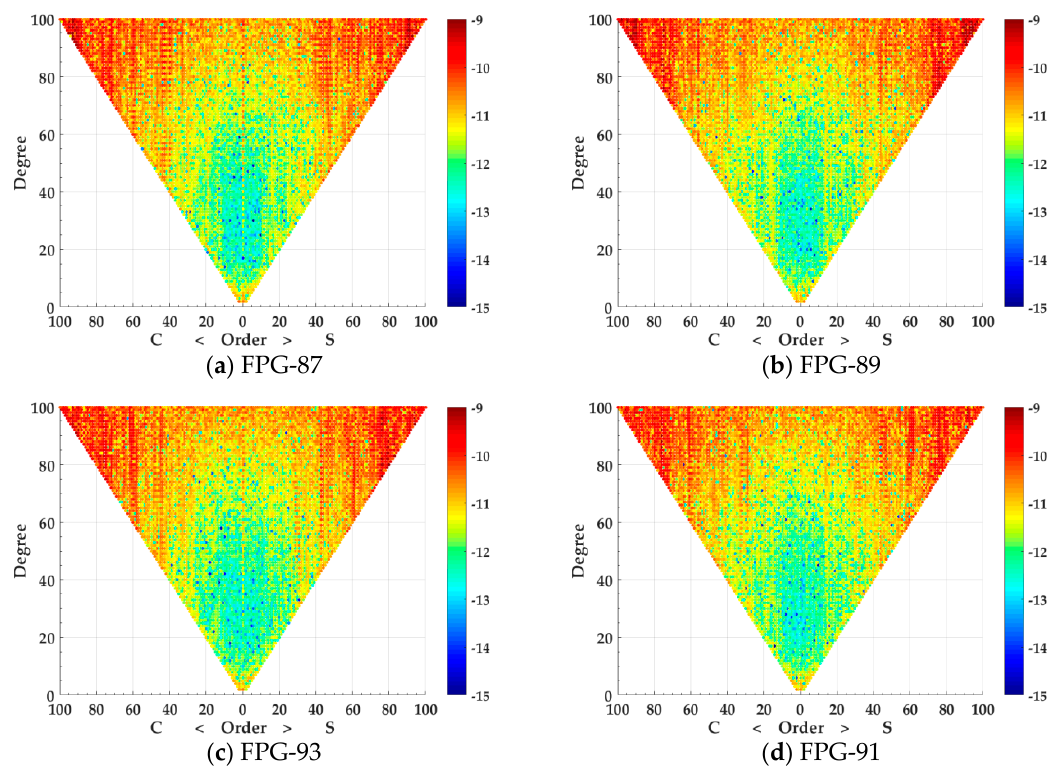
Figure 3. Absolute spherical harmonic coefficients (SHC) differences of different FPG standalone models in January, 2006: ( a ) FPG-87; ( b ) FPG-89; ( c ) FPG-93; ( d ) FPG-91.